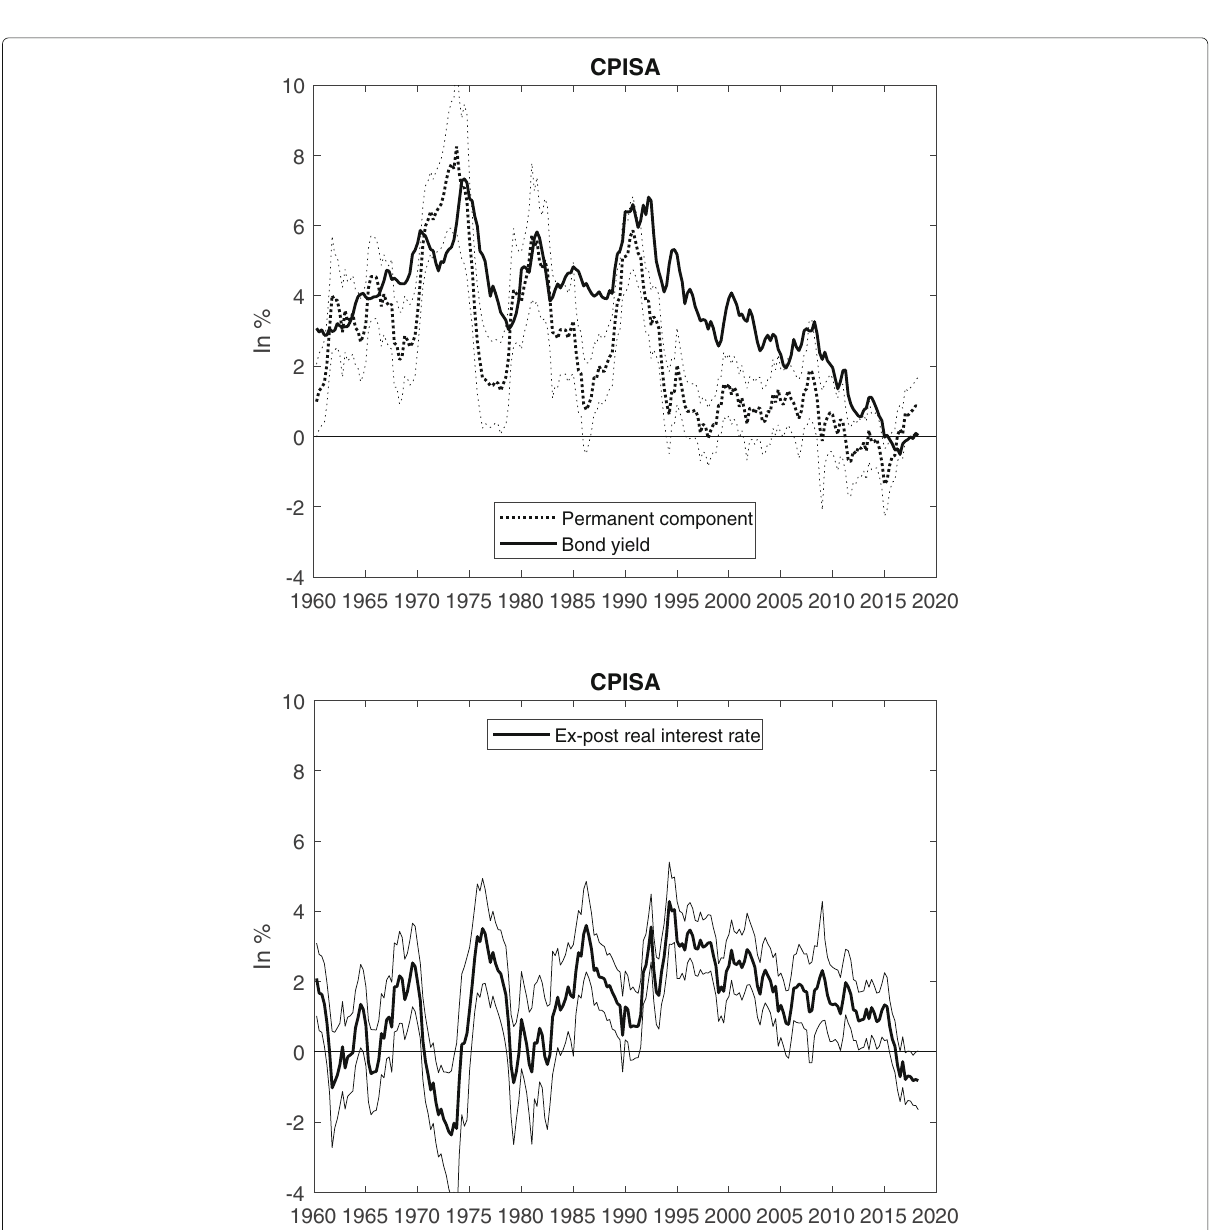
Fig. 8 Trend decline in bond yields and real interest rate (quarterly data). The solid lines in the left panel shows a quarterly measure of 10-year government bond yields. The dashed lines show the estimated permanent component of CPI inflation (mean, 5th percentile, 95th percentile). The right panel shows the implied ex-post real interest rate. The data stem from the OECD and were seasonally adjusted using TRAMO-SEATS via www.